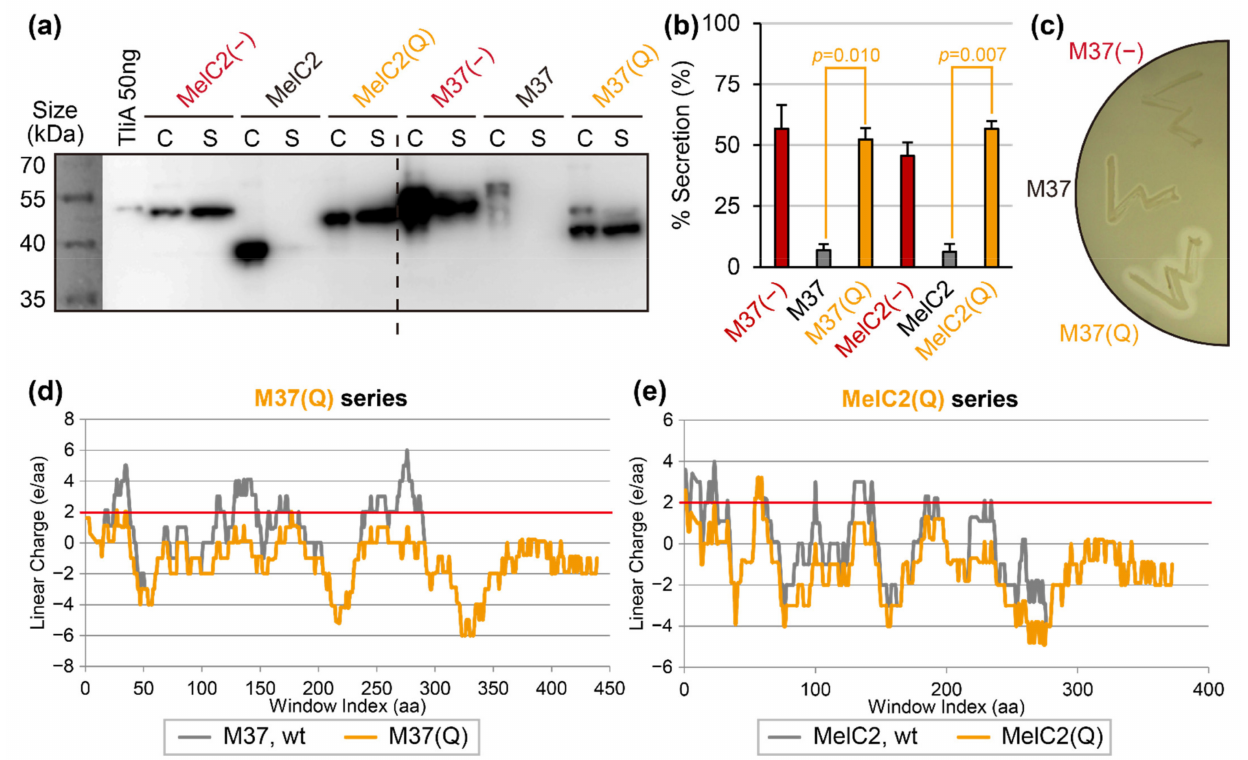
Figure 5. Secretion of proteins which were mildly mutated via super-neutralization. ( a ) The “super- neutralized” mutants, M37(Q) and MelC2(Q), were tested for secretion via Western blot. A signal in “S” implies secretion. ( b ) Quantification of results presented in panel ( a ). Error bars represent sample standard errors. ( c ) Enzymatic activity of M37 lipase and its derivatives developed in this study. A halo indicates that the protein had both been secreted and had enzymatic activity. ( d ) LCD graphs of M37(Q) and native M37 lipase. ( e ) LCD graphs of MelC2(Q) compared to native